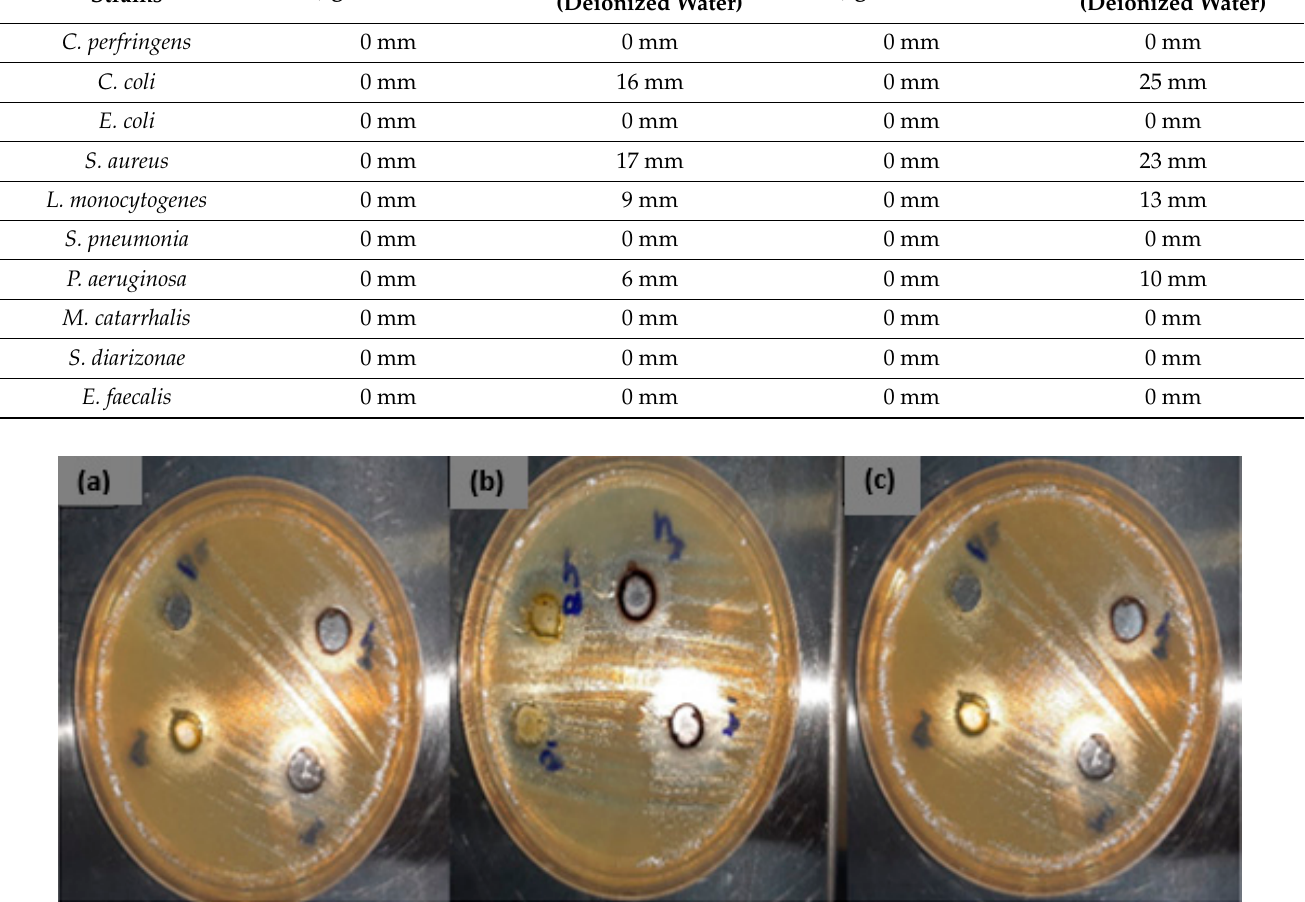
Figure 9. Antimicrobial sensitivity test of copper oxide nanoparticles. ( a ) Escherichia coli , ( b ) Campylobacter coli and ( c ) Staphylococcus aureus.